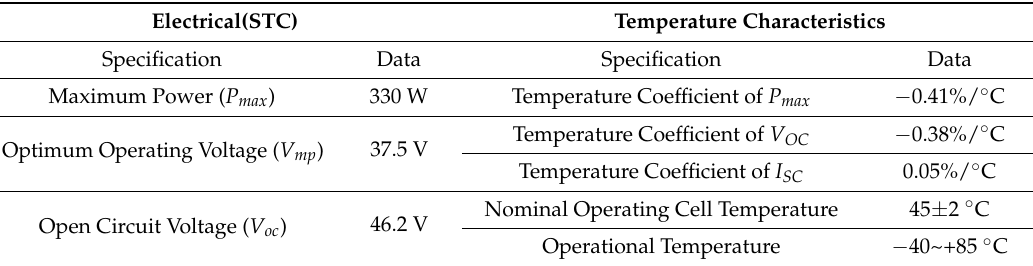
Table 3. Simulation PV module parameters.